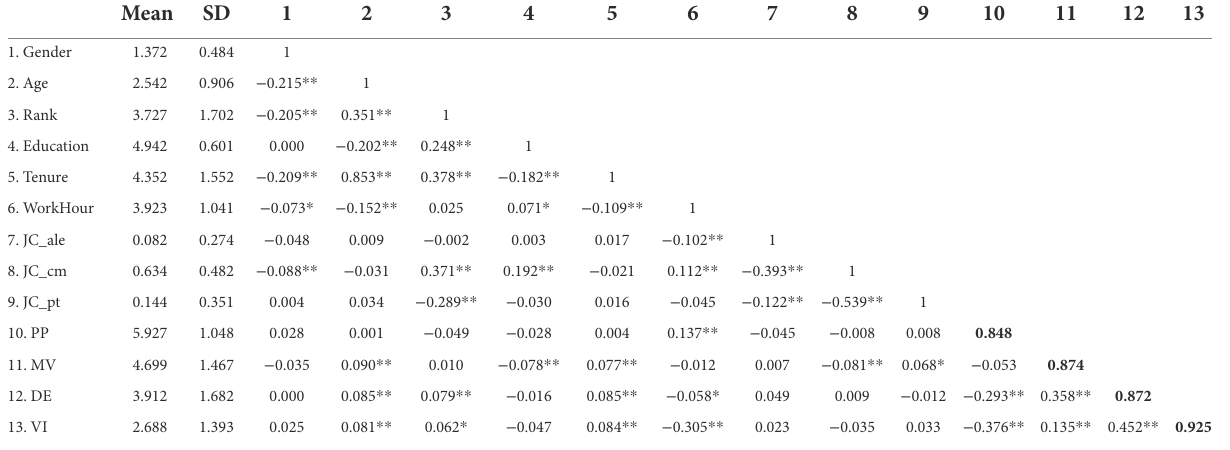
TABLE 5 Means, standard deviations, and correlations among variables.